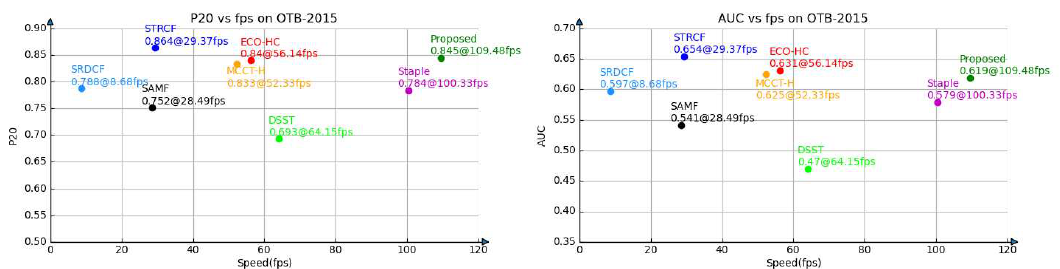
Figure 6. Performance efficiency plot on OTB-2015 of CRCF_ATU tracker and existing trackers.